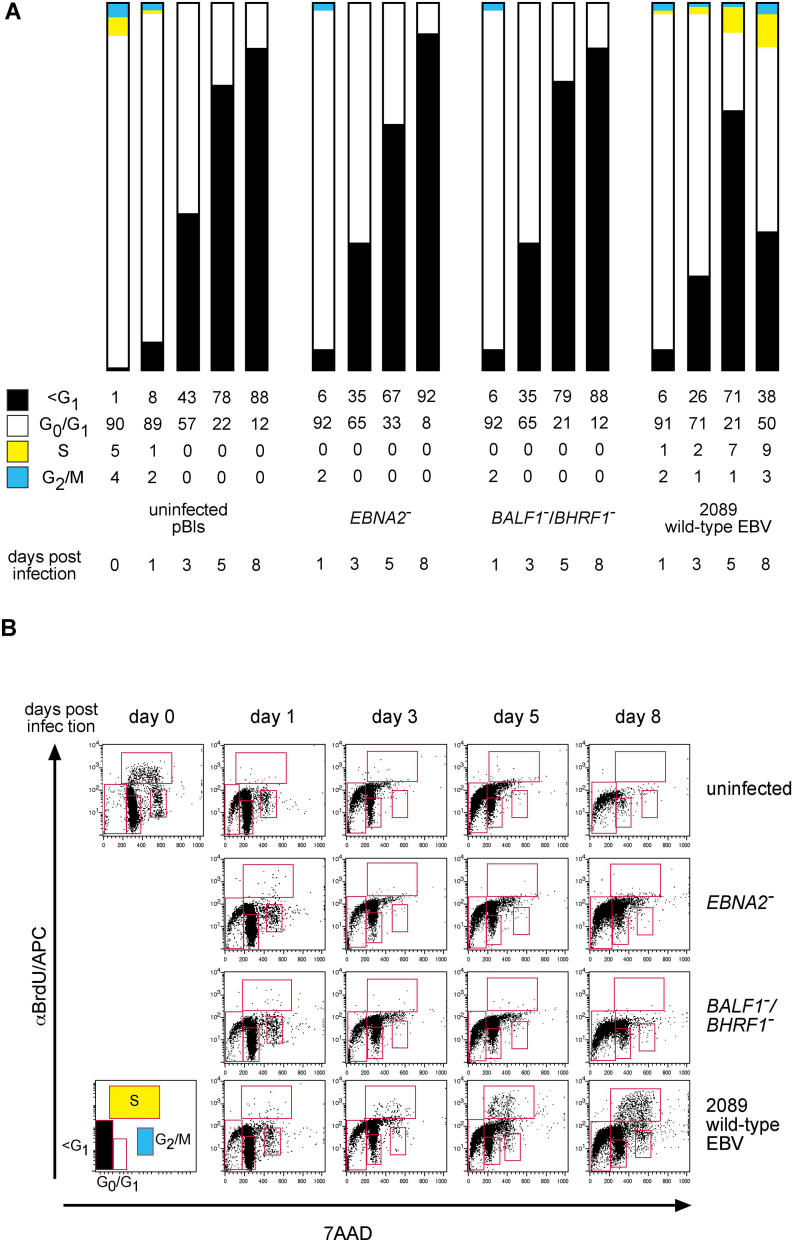
Cell Cycle Analysis of Uninfected Primary B Cells (PBls) or PBls Infected with EBNA2− Virus, BALF1−/BHRF1− Mutant 2636, or Wild-Type 2089 EBVPrimary B cells (105) per time point were infected with a viral dose such that about 50% of the cells were infected or left uninfected, and their cell cycle profiles were determined by BrdU incorporation and FACS analysis. Only wild-type 2089 EBV induced cell cycle progression, whereas uninfected cells as well as cells infected with the two mutants became apoptotic as indicated by their subG1 DNA content. (A) shows the compiled data of the primary results, which are illustrated in (B). One representative experiment out of three is shown.